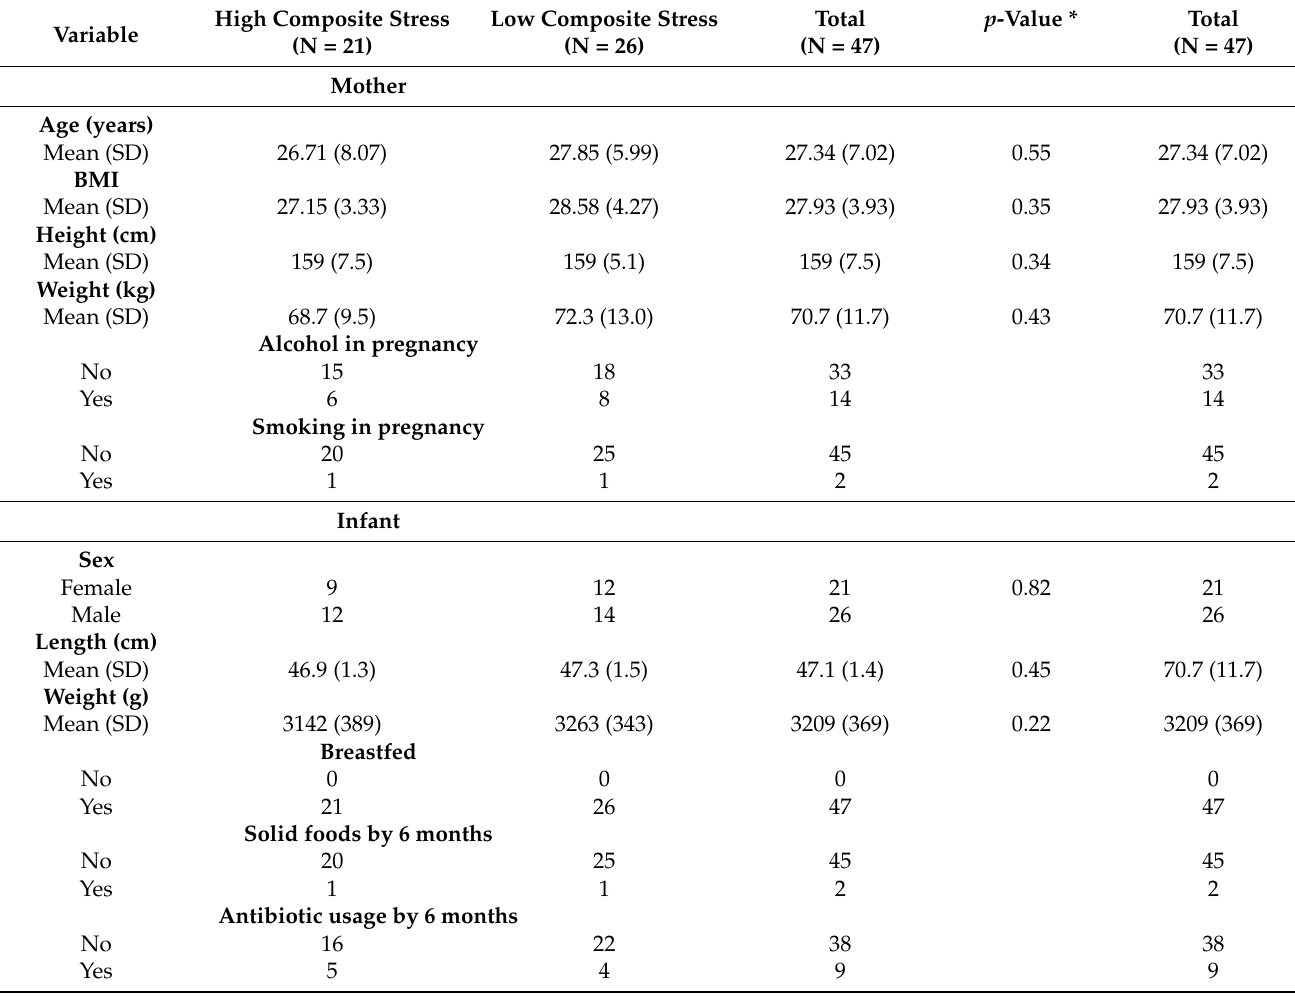
Table 1. Study population